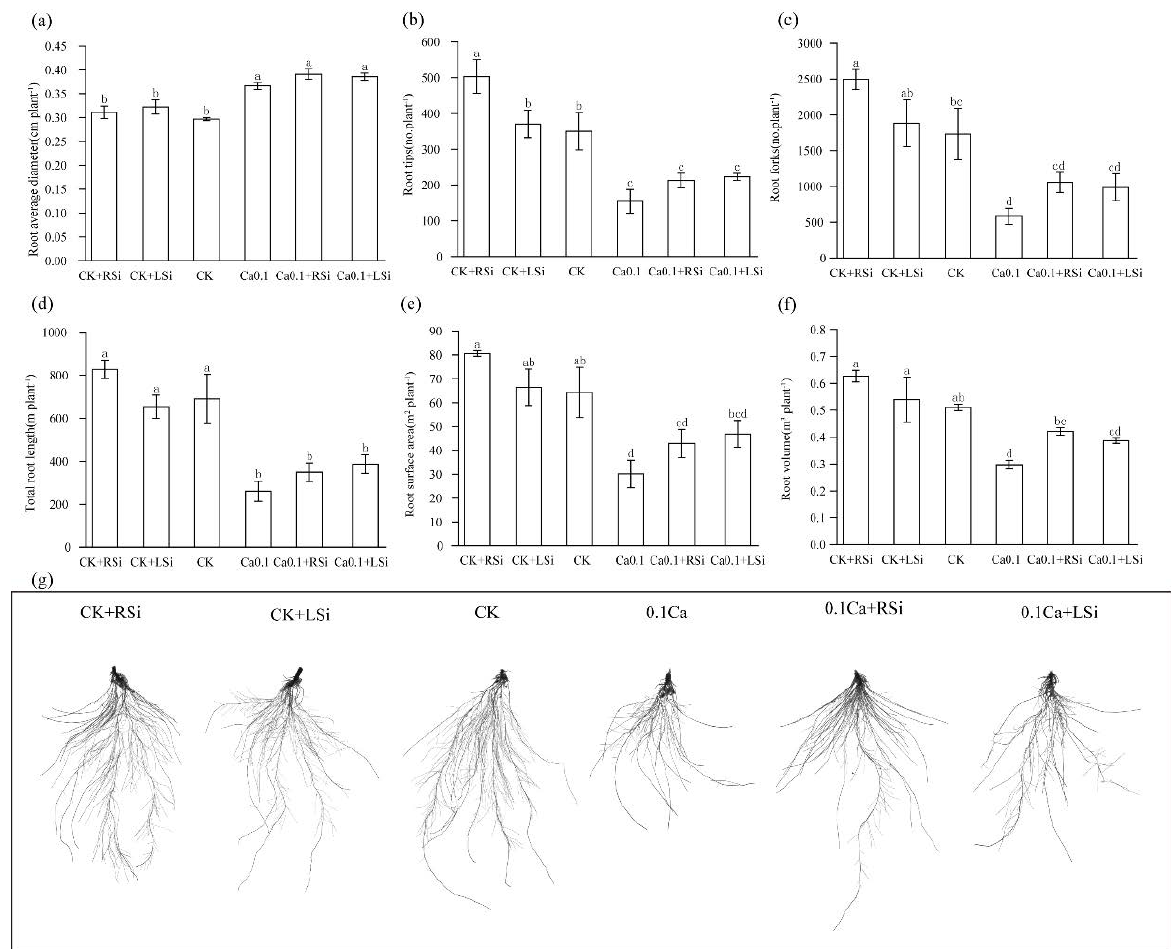
Figure 2. Effect of exogenous Si on tomato root system under low − calcium stress. ( a ) Root average diameter; ( b ) root tips; ( c ) root forks; ( d ) total root length; ( e ) root surface area; ( f ) root volume; ( g ) scan image of root morphology. The means of three replicates ± standard error is shown. The data were subjected to an ANOVA test to determine the LSD, and bars superscribed by different letters are significantly different at p < 0.05. Standard errors are indicated by bars. CK + RSi: 4 mM Ca in Hoagland nutrient solution + root application of 1 mM Si; CK + LSi: 4 mM Ca in Hoagland nutrient solution + foliar application of 1 mM Si; CK: 4 mM Ca in Hoagland nutrient solution; 0.1Ca: 0.1 mM Ca in Hoagland nutrient solution; 0.1Ca + RSi: 0.1 mM Ca in Hoagland nutrient solution + root application of 1 mM Si; 0.1Ca + LSi: 0.1 mM Ca in Hoagland nutrient solution + foliar application of 1 mM Si.